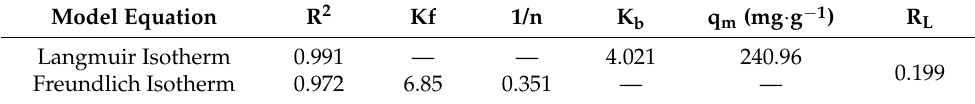
Table 2. Adsorption isotherm models, for adsorption Cr(VI) on MNPs/rGO/PMMA